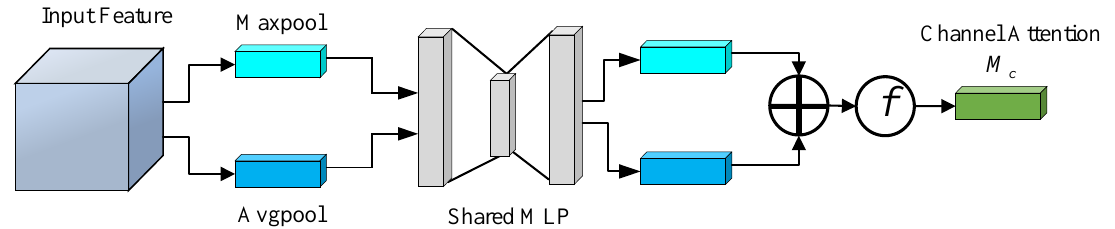
Figure 4. Channel attention module.